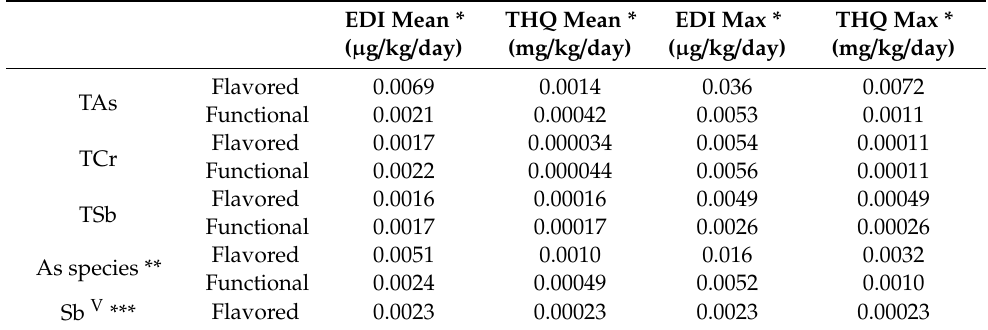
Table 2. Estimated daily intake (EDI) and target hazard quotient (THQ) values for flavored and functional bottled drinking water samples estimated for mean and maximal As, Cr, and Sb, as well as As and Sb species concentrations.